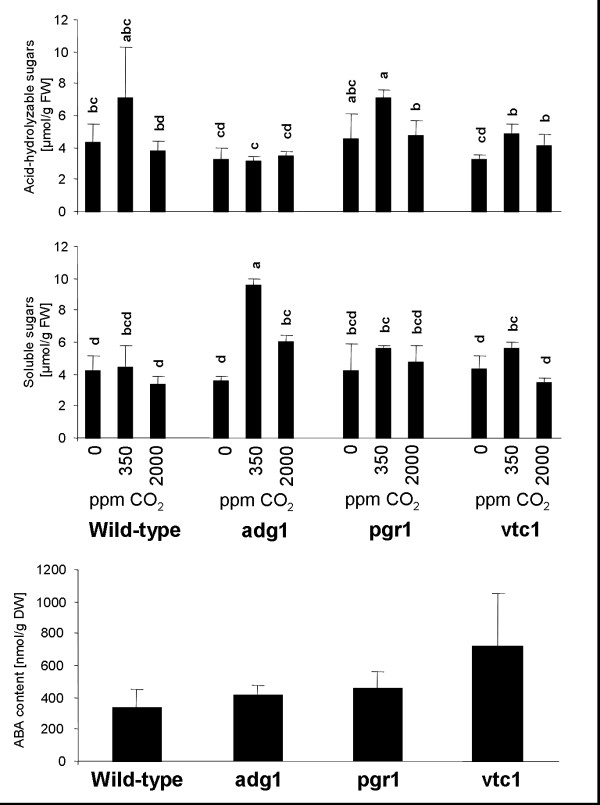
Content of soluble (A) and hydrolyzable sugars (B) in wt, adg1, pgr1 and vtc1 under different CO2 regimes (0 ppm, 350 ppm and 2000 ppm CO2). The data are means of n = 4–6, ± SE from at least 4 different experiments. Abscisic acid (ABA) content (C) in wt, adg1, pgr1 and vtc1 after fumigation with 350 ppm CO2. The data are means of n = 3 ± SE.